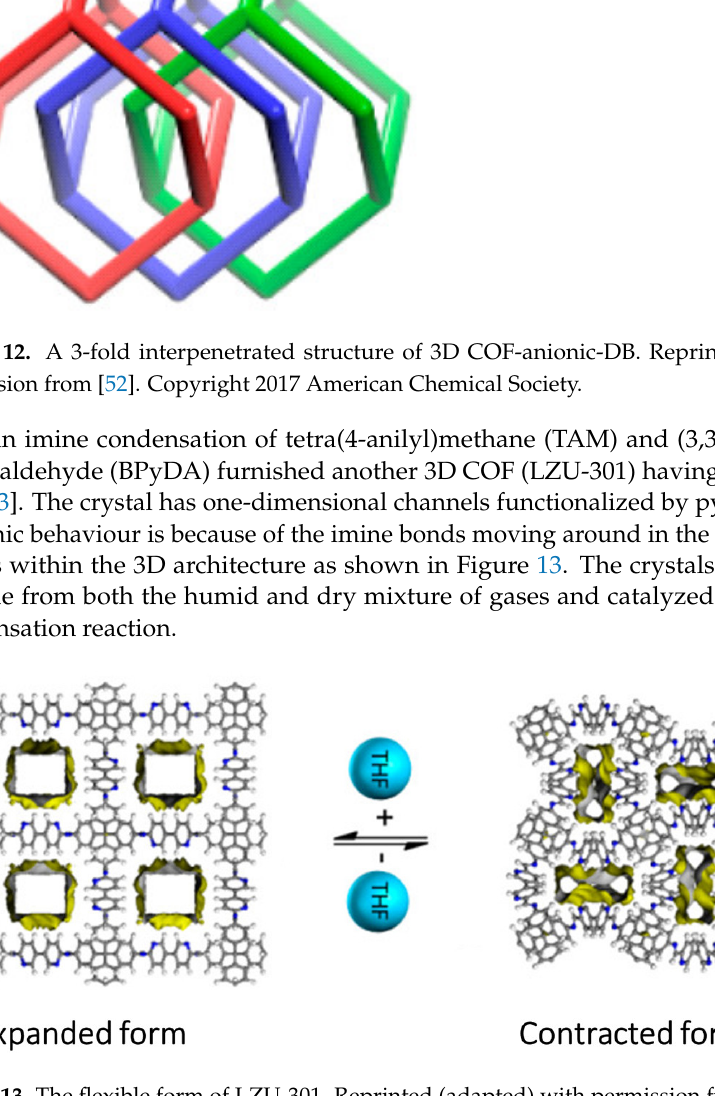
Figure 13. The flexible form of LZU-301. Reprinted (adapted) with permission from [53]. Copyright 2017 American Chemical Society.